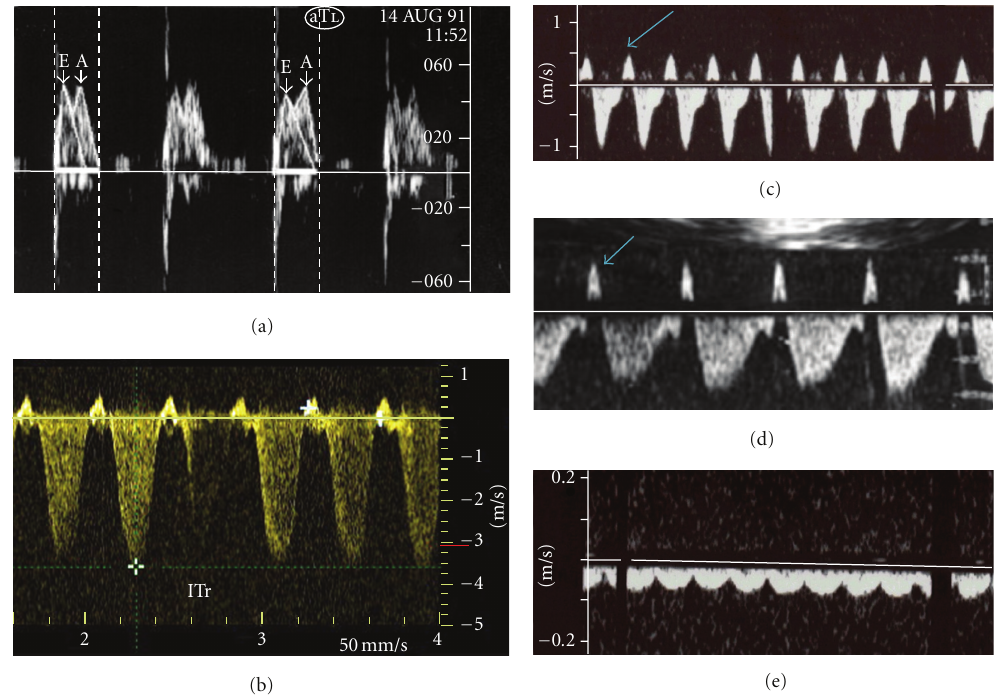
Figure 2: Doppler findings in fetuses with DCM and fetal hydrops: (a) The tracing of the tricuspid valve (T) shows a reduced systolic A- wave, with respect to the diastolic E-wave; (b) holosystolic tricuspid regurgitation (ITr); (c) a reverse systolic flow of the inferior vena cava (small arrow); (d) a reverse systolic flow of ductus venosus (small arrow); (e) the fluctuation of the umbilical vein. mild-initial hydrops that presented at 20 w.g. and another one who presented late at 37 w.g. without hydrops